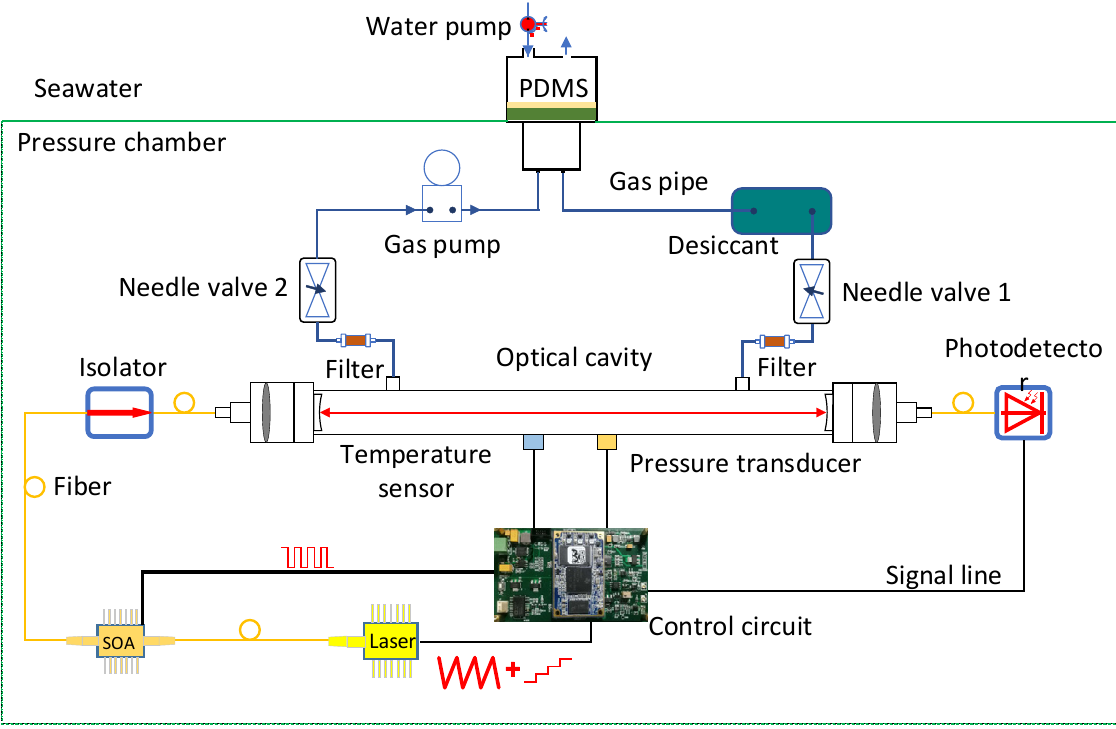
Figure 2. Framework of in-situ underwater instrument for dissolved gas measurement.